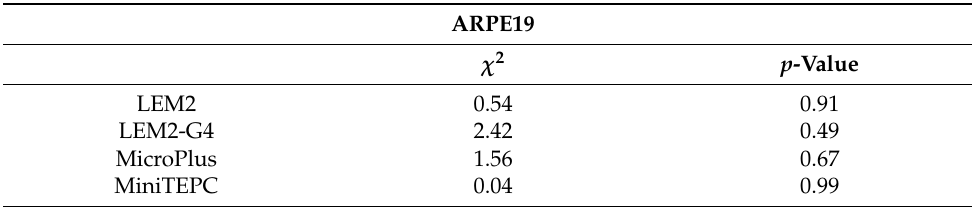
Table 6. Results of the χ 2 test for the comparison of the experimental survival curves of ARPE19 cells against the survival fraction calculated with the LEM II, Geant4 coupled with LEM II and the Loncol’s function applied with the microdosimetric spectra obtained with the two detectors. The corresponding χ 2 probabilities are calculated for four degrees of